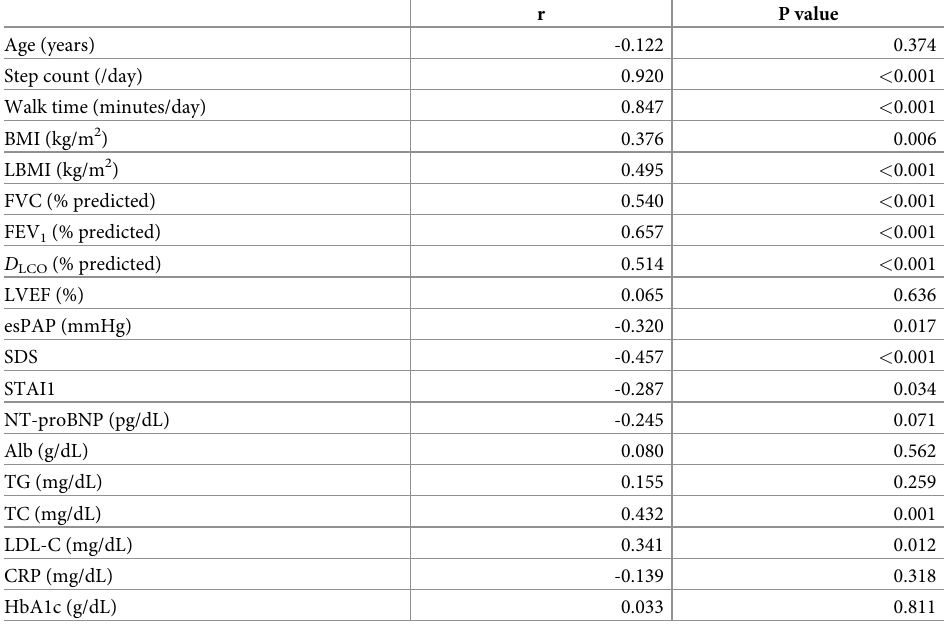
Table 3. Relationship between physical activity and clinical characteristics assessed using Spearman’s rank corre- lation coefficient.